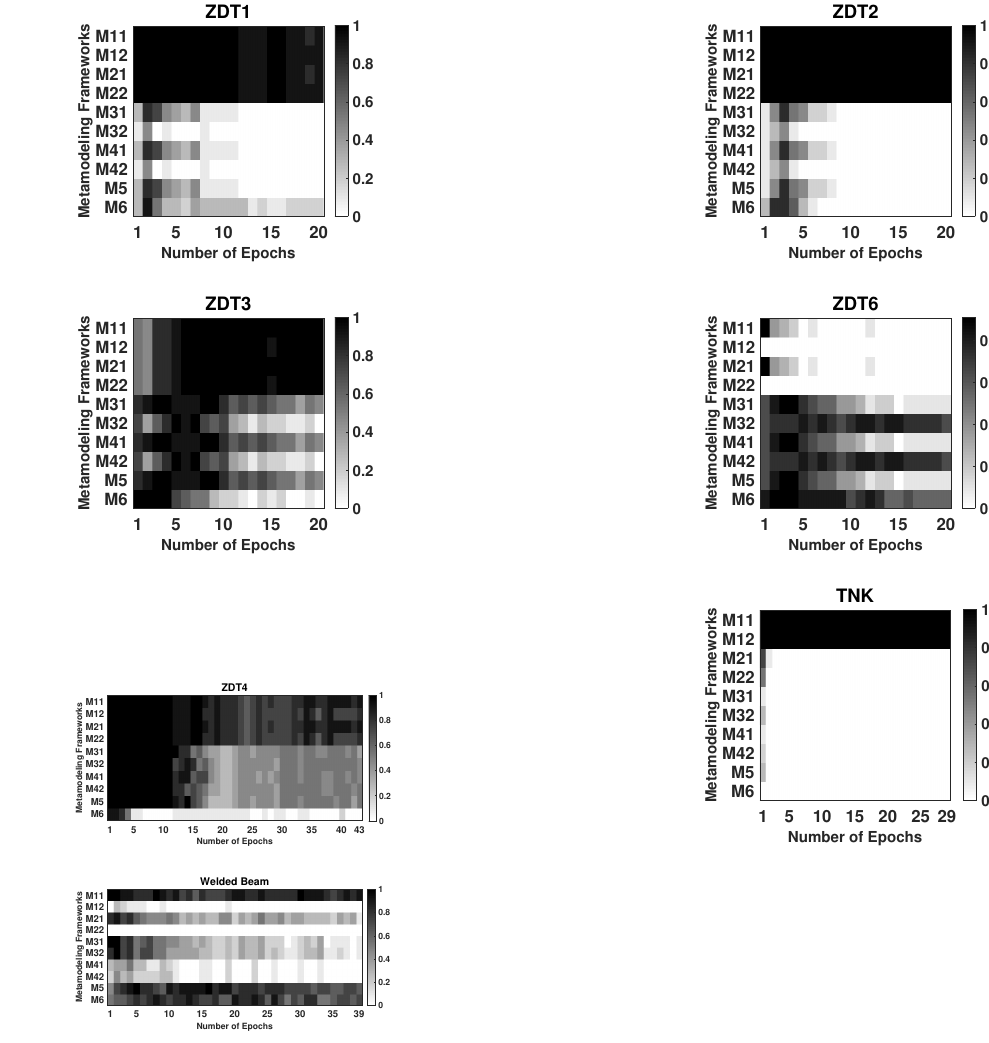
Figure 8. Epoch-wise proportion of appearance of 10 frameworks within M B in 11 runs of the ASM approach for ZDT problems, TNK, and welded beam design problems indicates the use of multiple frameworks during optimization. Some problems uses some specific frameworks more frequently.